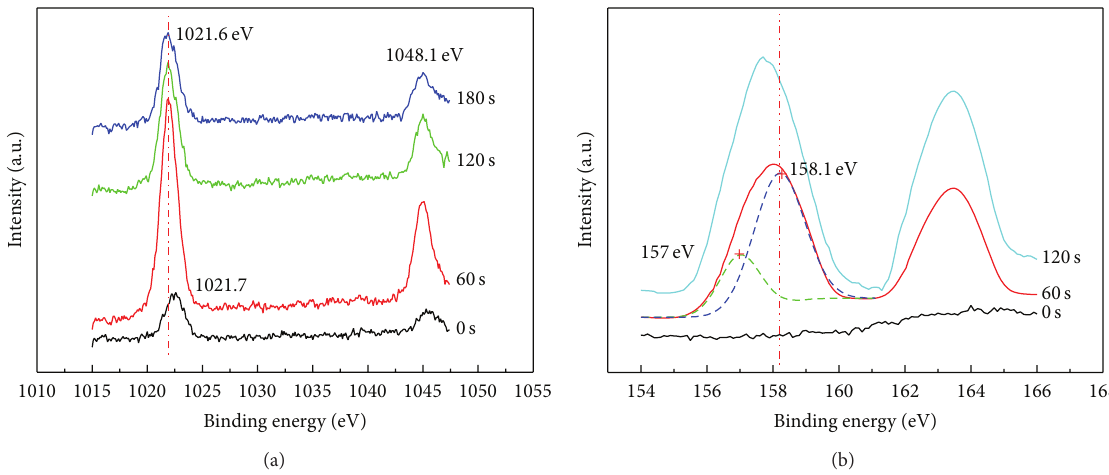
Figure 5: Spectra of (a) Zn 2p and (b) Bi 4f in SBZ sample oxidized at 170 ∘ C for 7min after etching for various